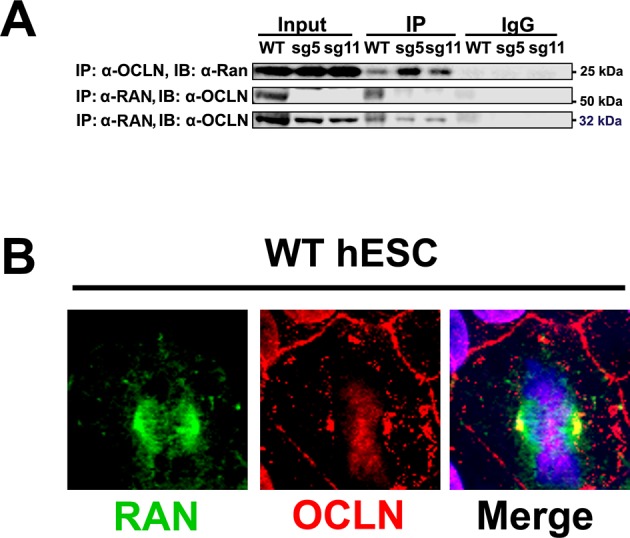
OCLN interacts with mitotic spindle protein RAN.(A) Immunoprecipitation of endogenous OCLN protein with anti-OCLN antibody and of endogenous Ran protein with anti-Ran from hESCs. Immunoprecipitated proteins (IP) were analyzed by immunoblotted (IB) with indicated antibodies. The input represents about 3% of total lysate. Non-specific IgG used as negative control. (B) Confocal microscope images of WT hESCs stained with Ran (green) and OCLN (red) antibodies. DAPI (blue) was used for nuclear stain.